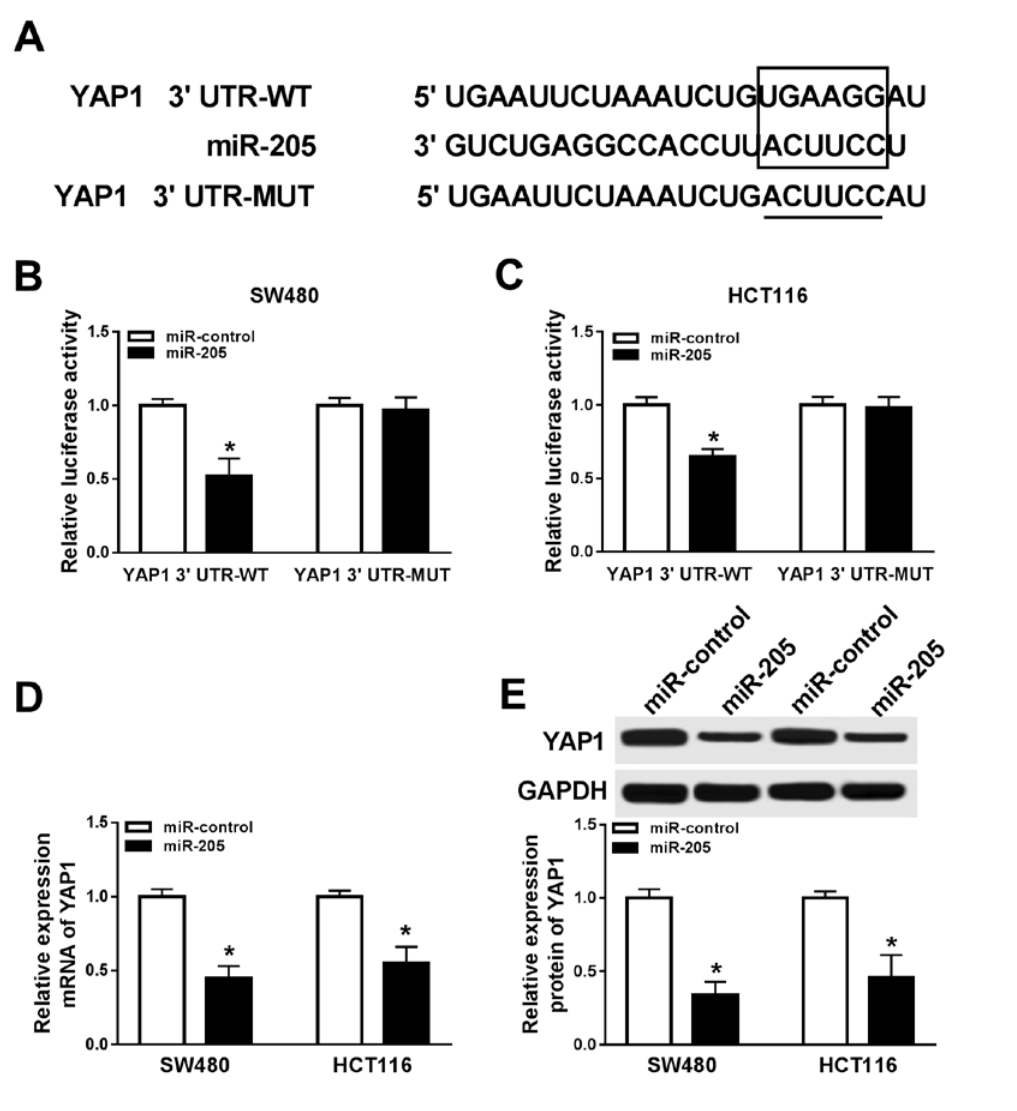
Figure 5: miR-205 directly interacts with YAP1 (A) The relationship between miR-205 and YAP1 predicted by TargetScan Tools. (B) Luciferase assay of WT-YAP1/MUT-YAP1 and miR-205 in SW480 cells. (C) Luciferase assay of WT-YAP1/MUT-YAP1 and miR-205 in HCT116 cells. (D) YAP1 mRNA expression in SW480 and HCT116 cells after overexpression of miR-205. (E) YAP1 protein expression in SW480 and HCT116 cells after overexpression of miR-205. * means p <